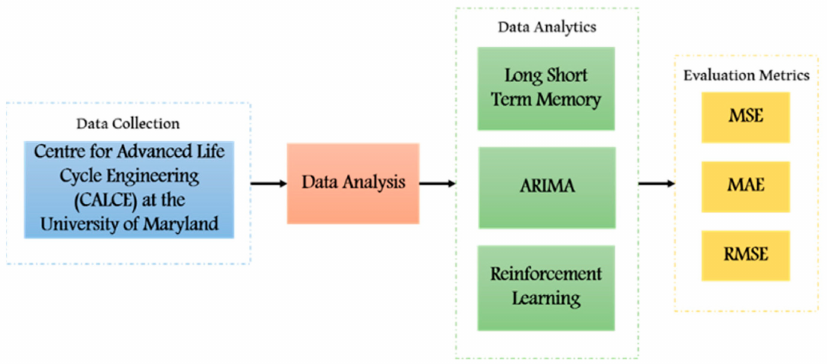
Figure 1. Prediction system for the lithium-ion batteries.